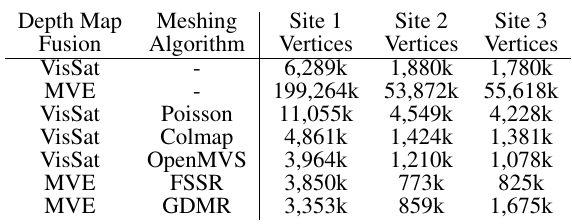
Table 4. Parameter configuration of the meshing algorithms used for the quantitative evaluations.